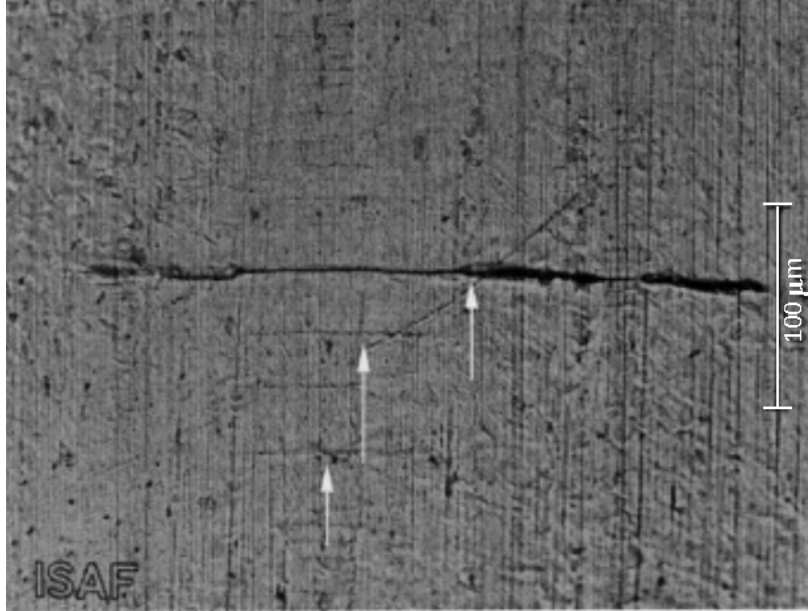
Figure 11. Image of the surface of the AlMgSi1 test object after being given a torsional dynamic load, a = 0.76%, N = 870 cycles, the arrows show the cracks. ISAF is Institut für Schweißtechnik und Trennende Fertigungsverfahren, Germany.